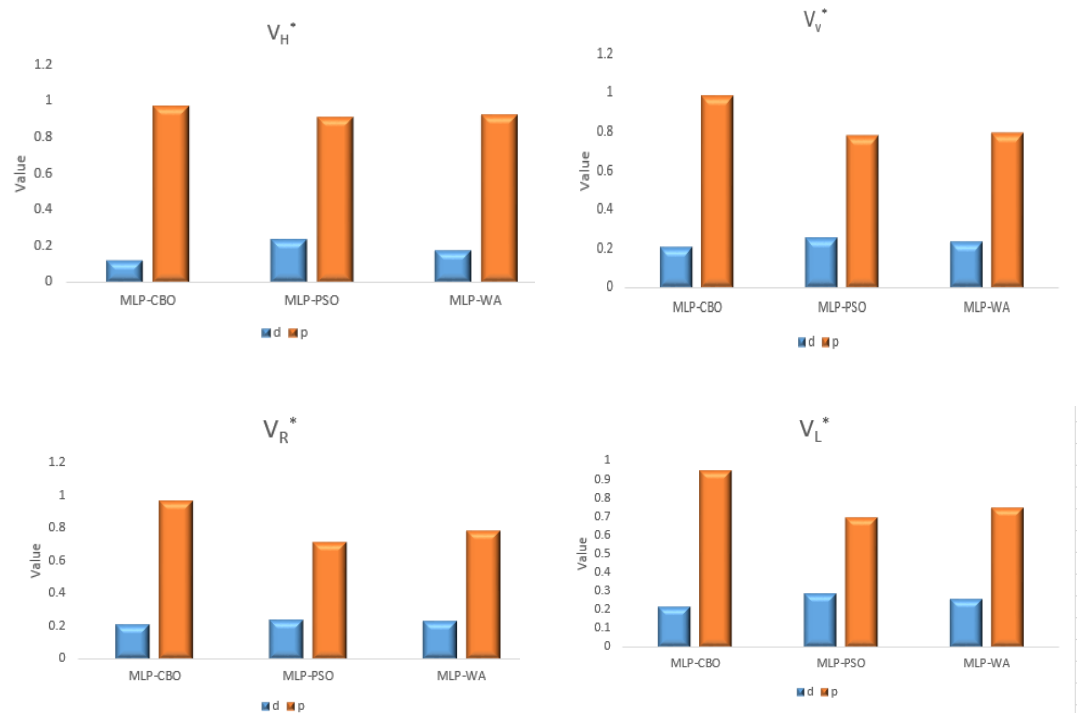
Figure 11. Results of uncertainty analysis of soft computing models using d and p indices.